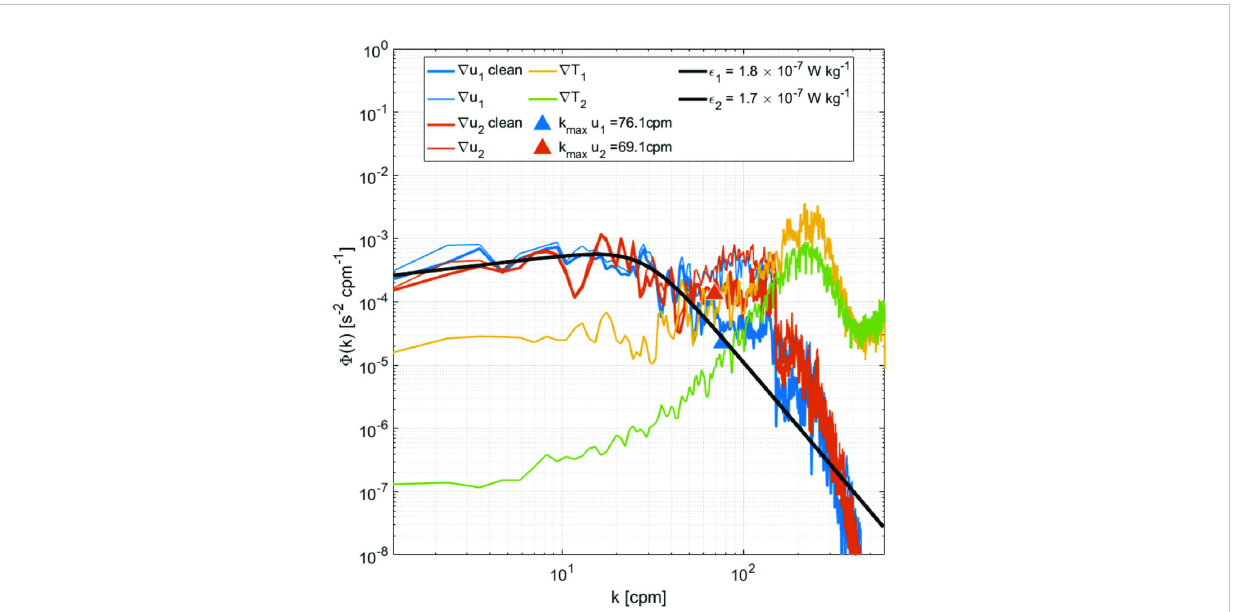
FIGURE 9 VMP microstructure example spectra showing temperature gradient ( ∇ T 1,2 ) and microscale velocity shear ( ∇ u 1,2 ) where the thin and thick lines show raw and fi ltered response. The black line is modelled energy spectra distribution for e =1.6-1.7x10 -7 W kg -1 . The signal to the right of the triangles is ampli fi ed noise (Wolk et al.,